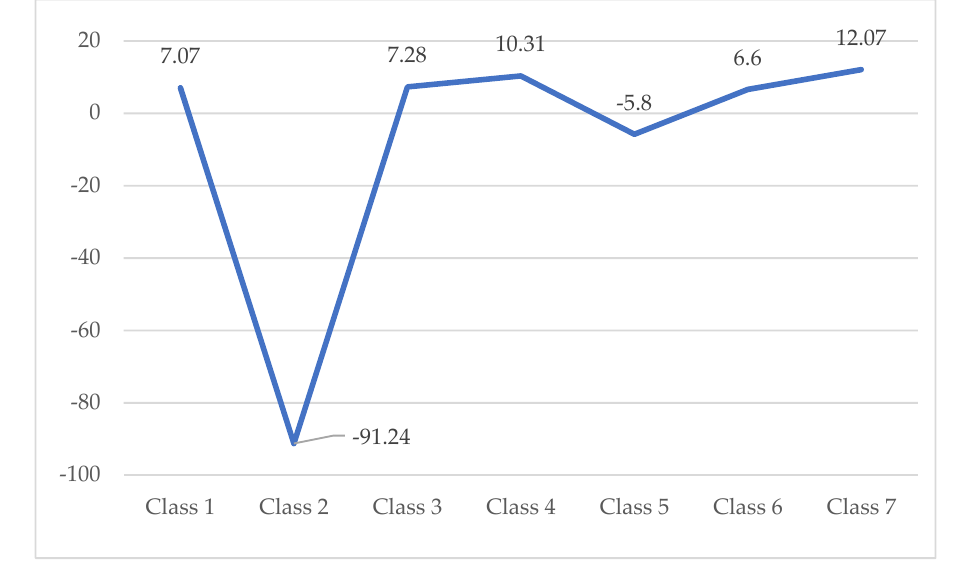
Figure 5. Annual average evolution of the number of employees per industry (persons). Source: